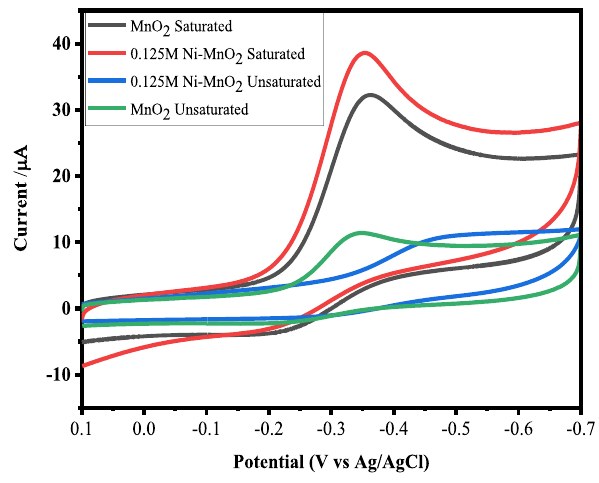
Fig. 12 CV curve of saturated and unsaturated MnO Ni-doped MnO